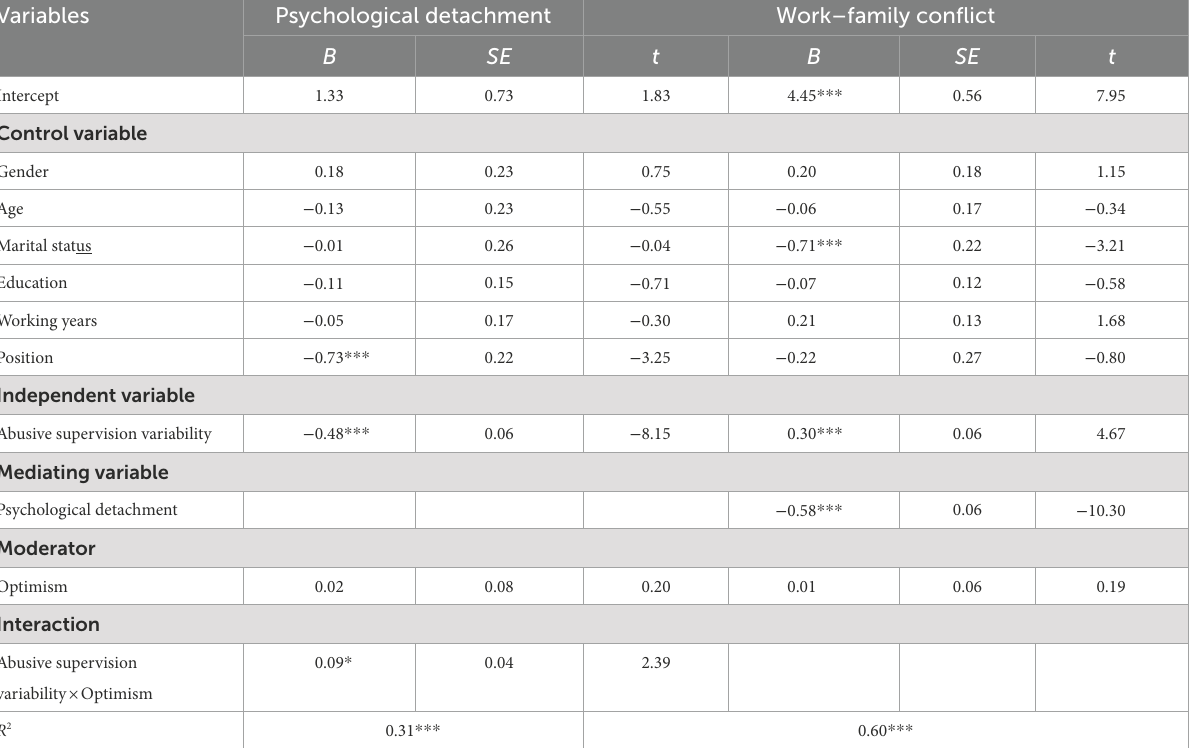
TABLE 3 Model testing result.